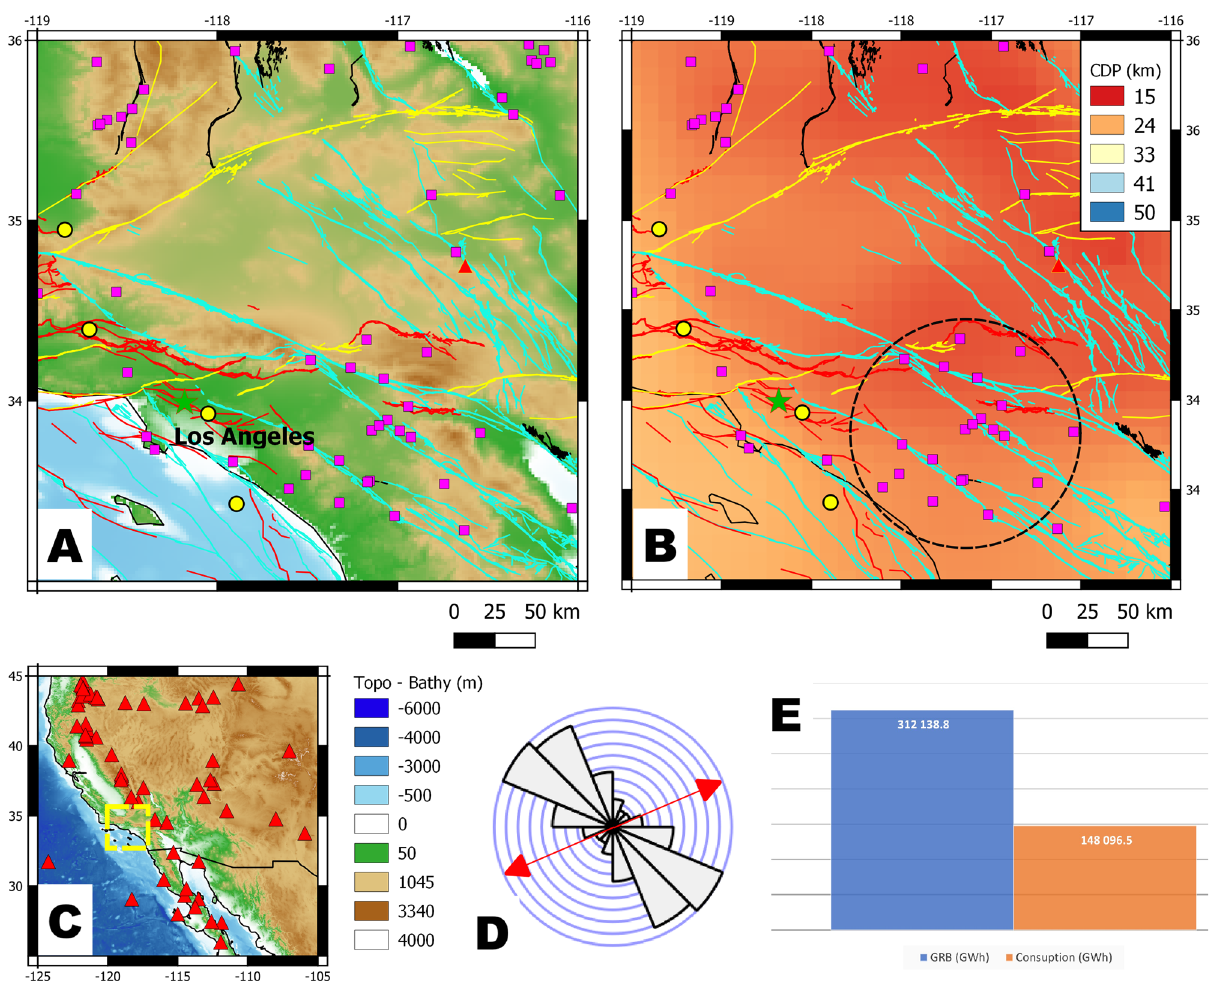
Fig. 3 Geothermal system of Los Angeles. A Spring water distribution (purple squares) in the area of Los Angeles. B Calculation of the Curie Point Depth (CPD) in the area north of Bogotá 54 . Black-dashed ellipse represents a hypothetical envelope encompassing the main geothermal leads. Maps display normal faults (blue lines), reversal faults (red lines), right-lateral faults (cyan lines), left-lateral faults (yellow lines), active volcanoes (red triangles), and O&G fi elds (yellow dots). Topography from Amante and Eakins 59 . Black-dashed ellipse corresponds to the hypothetical envelope that encompasses the main geothermal lead. C Study area in a regional context; D rose diagram showing regional fault trending and the maximum principal stress direction (red arrows showing compressive regime); Rose diagrams are expressed in eight intervals of azimuth to the respective length of faulting. E Comparison between the potential geothermal power expressed as GRB (estimated in this work) and the current energy consumption in the metropolitan area of Los Angeles. Coordinate system in